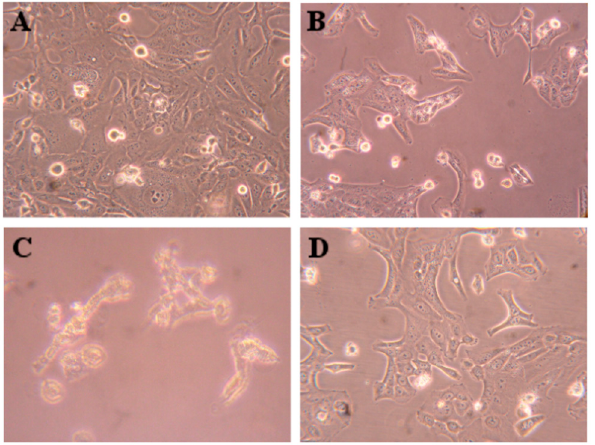
Figure 5. Microscopic visualization of HepaRG cells ( A ), control treated with compound 4 ( B ), compound 5 ( C ), and 5-fluorouracil ( D ) at 50 µM for 24 h. Amplification of 100×.